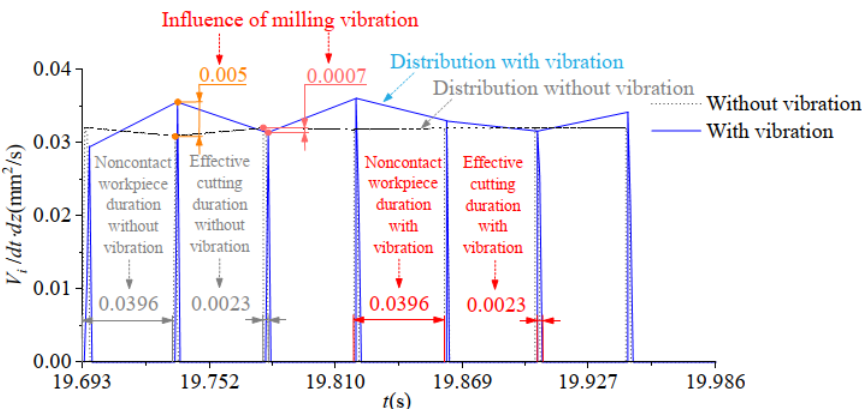
Table 3. Boundary conditions of finite element simulation.